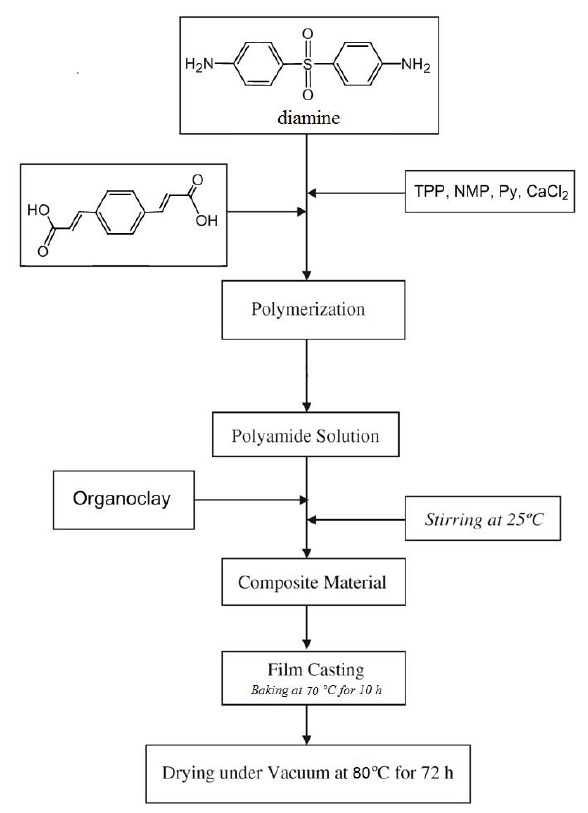
Figure 3. Scheme 3 of flow sheet diagram for the synthesis of PA-nanocomposites film 5a–5c.